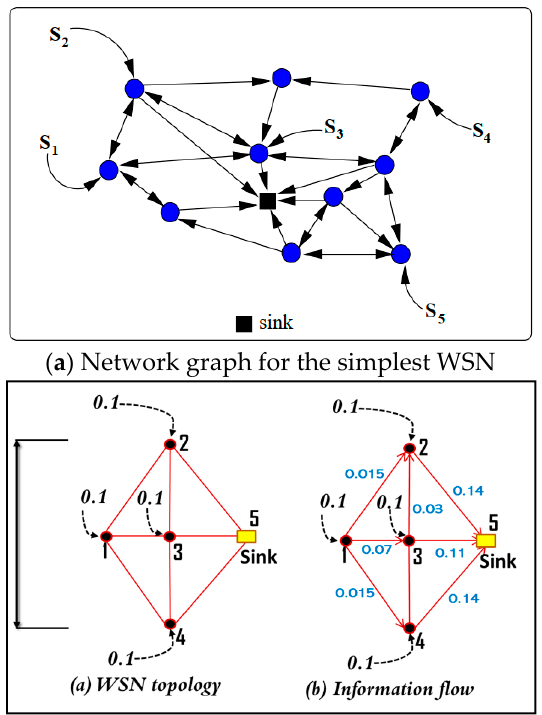
Figure 18. Overview of the WSN modeling as a graph and load balancing to maximize WSN’s lifetime.